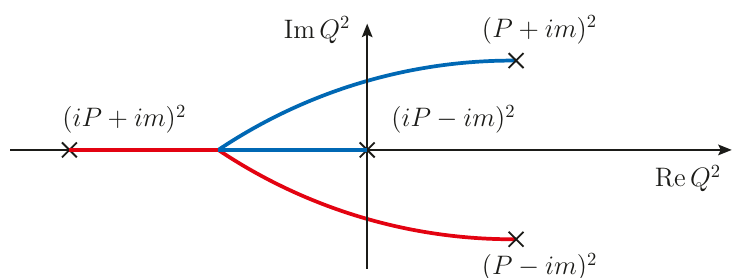
Figure 9. Location of the branch points of Z 1 , in the Q 2 plane. The path shows how these branch points moves as P 2 is varied from a positive value to 1